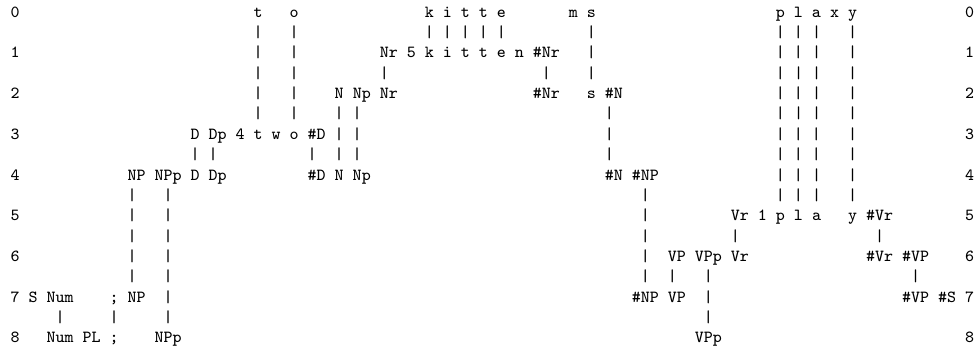
Figure 4. As in Figure A3 but with errors in the sentence in row 0 (‘ t o k i t t e m s p l a x y Figure 4: As in Figure 13 but with errors in the sentence in row 0 (‘ t o k i t t e m s p l a x y ’): an error of omission (‘ t o ’ instead of ‘ t w o ’), an error of substitution (‘ k i t t e m s ’ instead of ‘ k i t t e n s ’), and an error of addition (‘ p l a x y ’ instead of ‘ p l a y ’). Adapted from Figure 2 in [45].